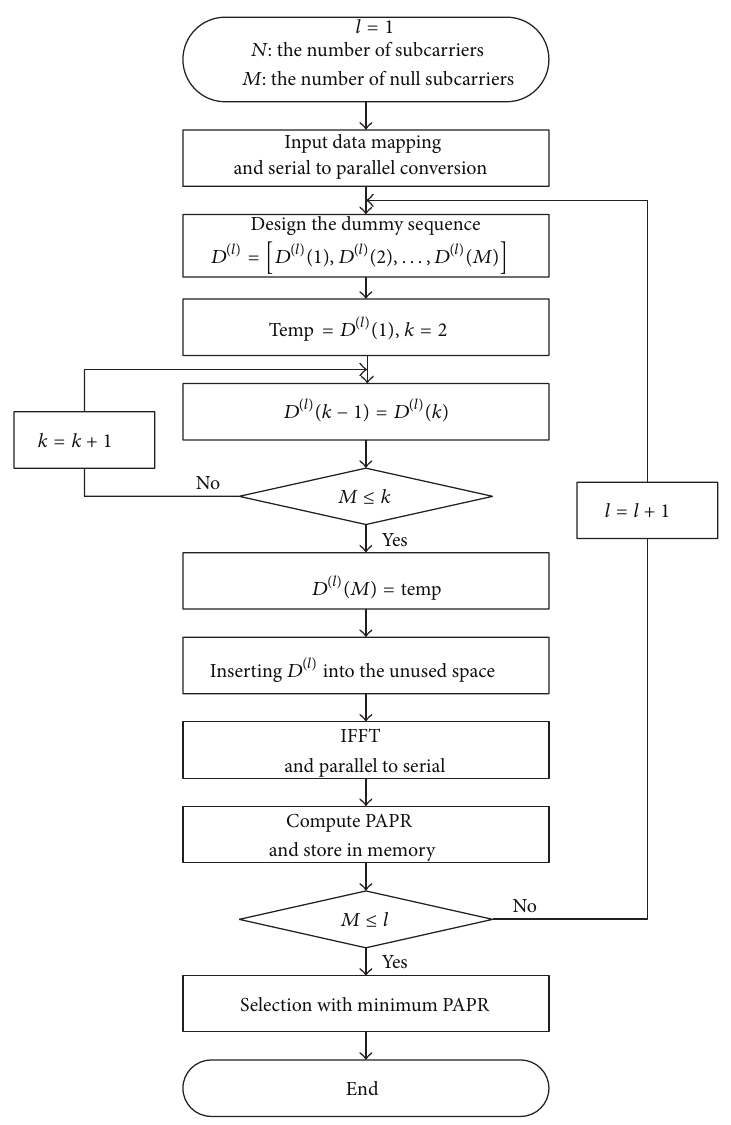
Figure 4: Flow chart of scheduling the null subcarriers for peak power